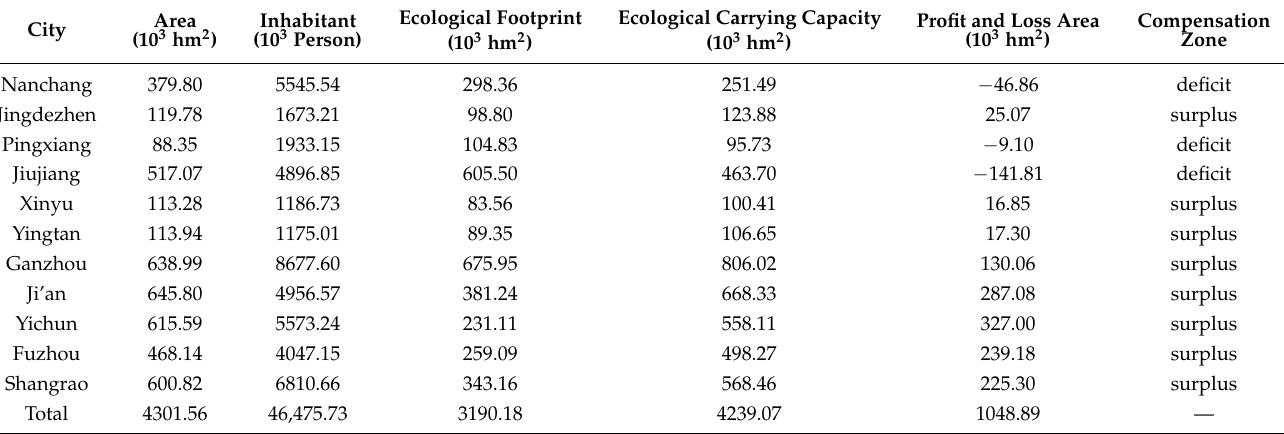
Table 3. Ecological surplus of cultivated land resource assets in various cities of Jiangxi province.